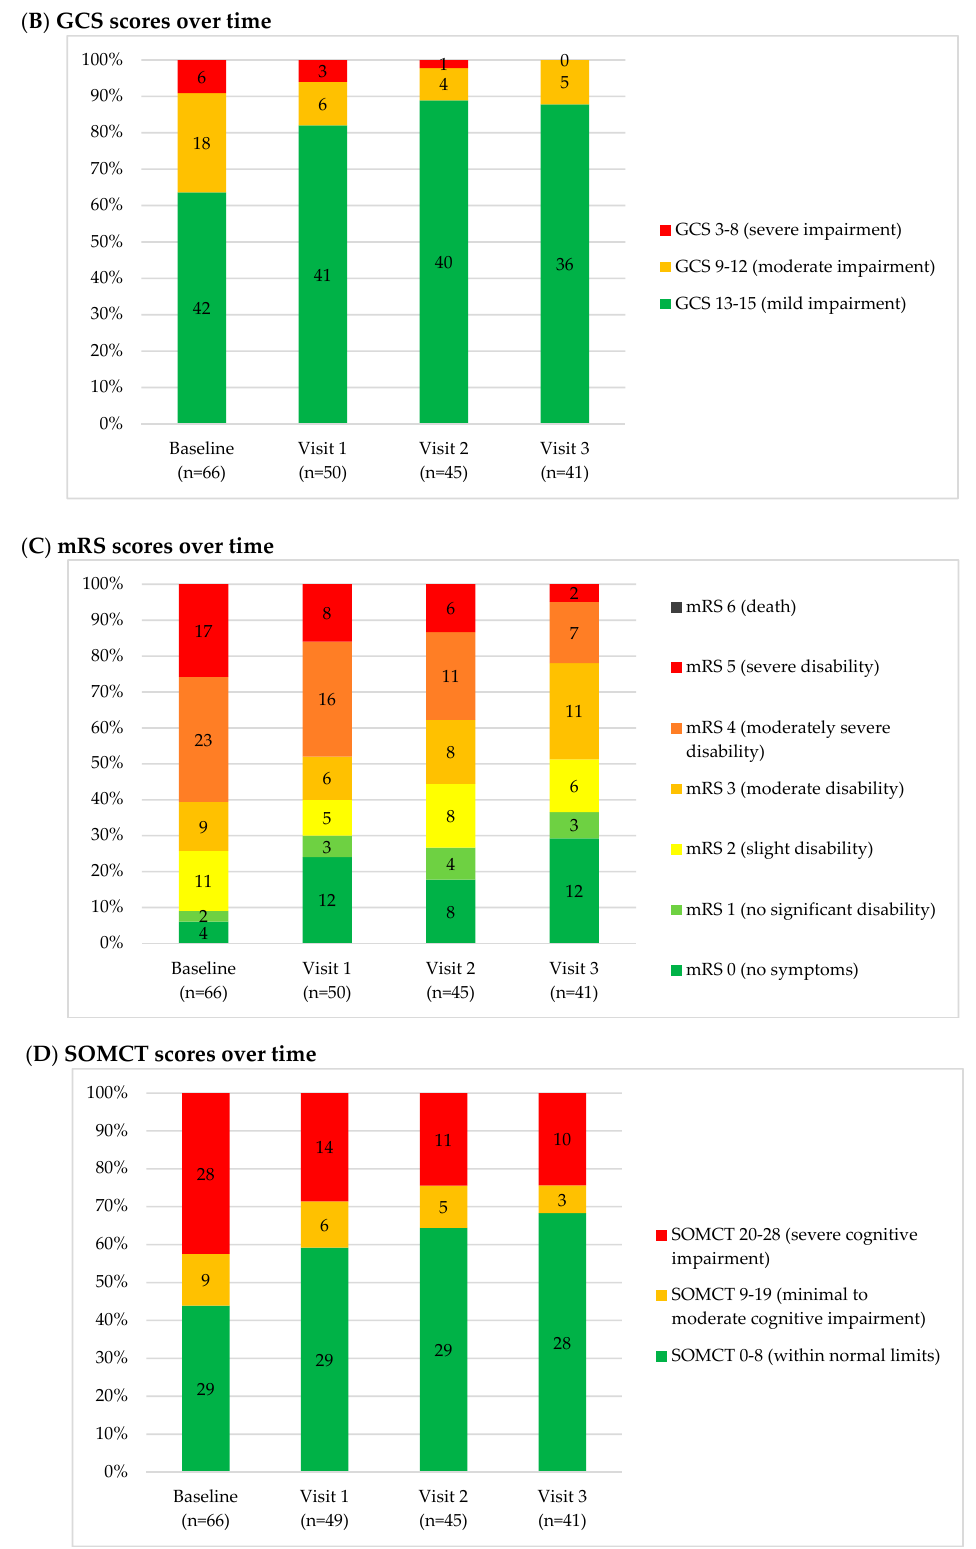
Figure 1. 100% stacked bars. (A) National Institutes of Health Stroke Scale (NIHSS) scores over time. (B) Glasgow Coma Scale (GCS) scores over time. (C) modified Rankin Scale (mRS) scores over time. (D) Short Orientation-Memory-Concentration Test (SOMCT) over time. Indicated inside the bars is n for each category.